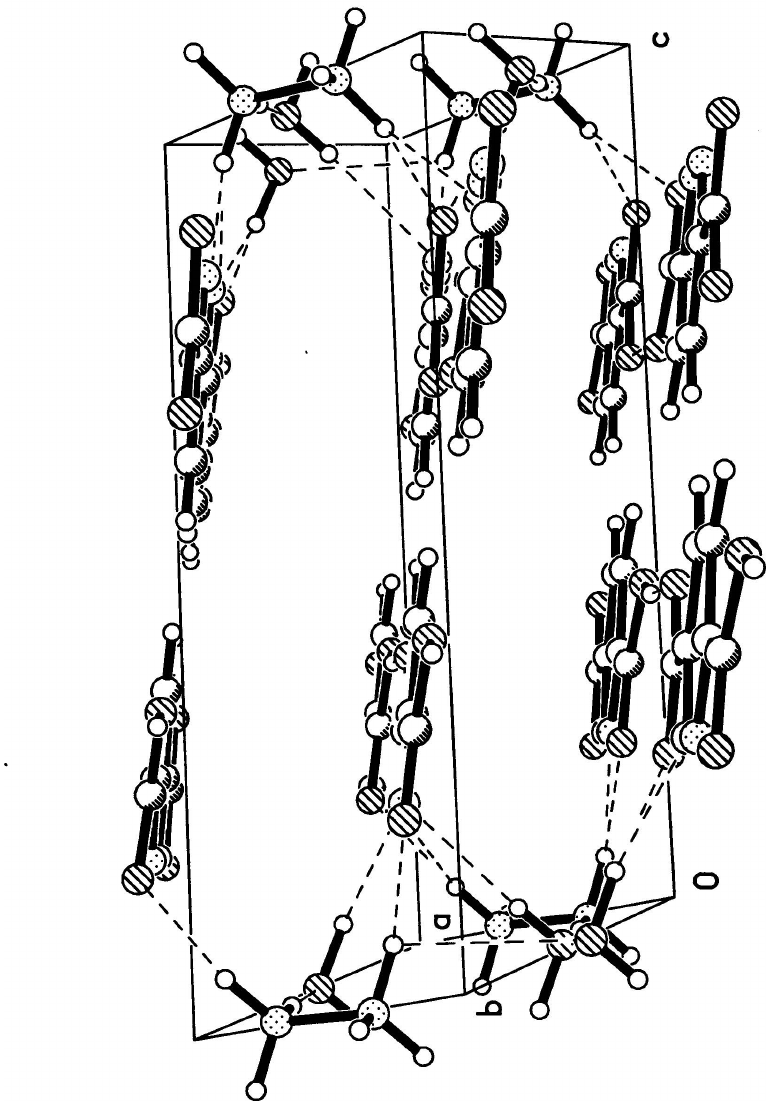
Packing diagram of the structure of